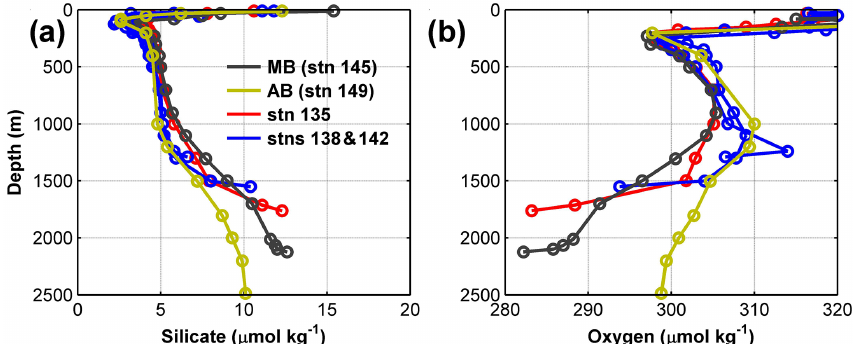
Figure 5. Silicate (a) and dissolved oxygen (b) from bottle data (circles show sampling depth) in the southern passage (stns. 135, 138 and 142) compared with reference stations in the Makarov Basin (MB) and Amundsen Basin (AB). For positions of the stations, please refer to Figs. 1 and 2. Station 149 is located in the westward direction next to station 148 as shown in Fig.